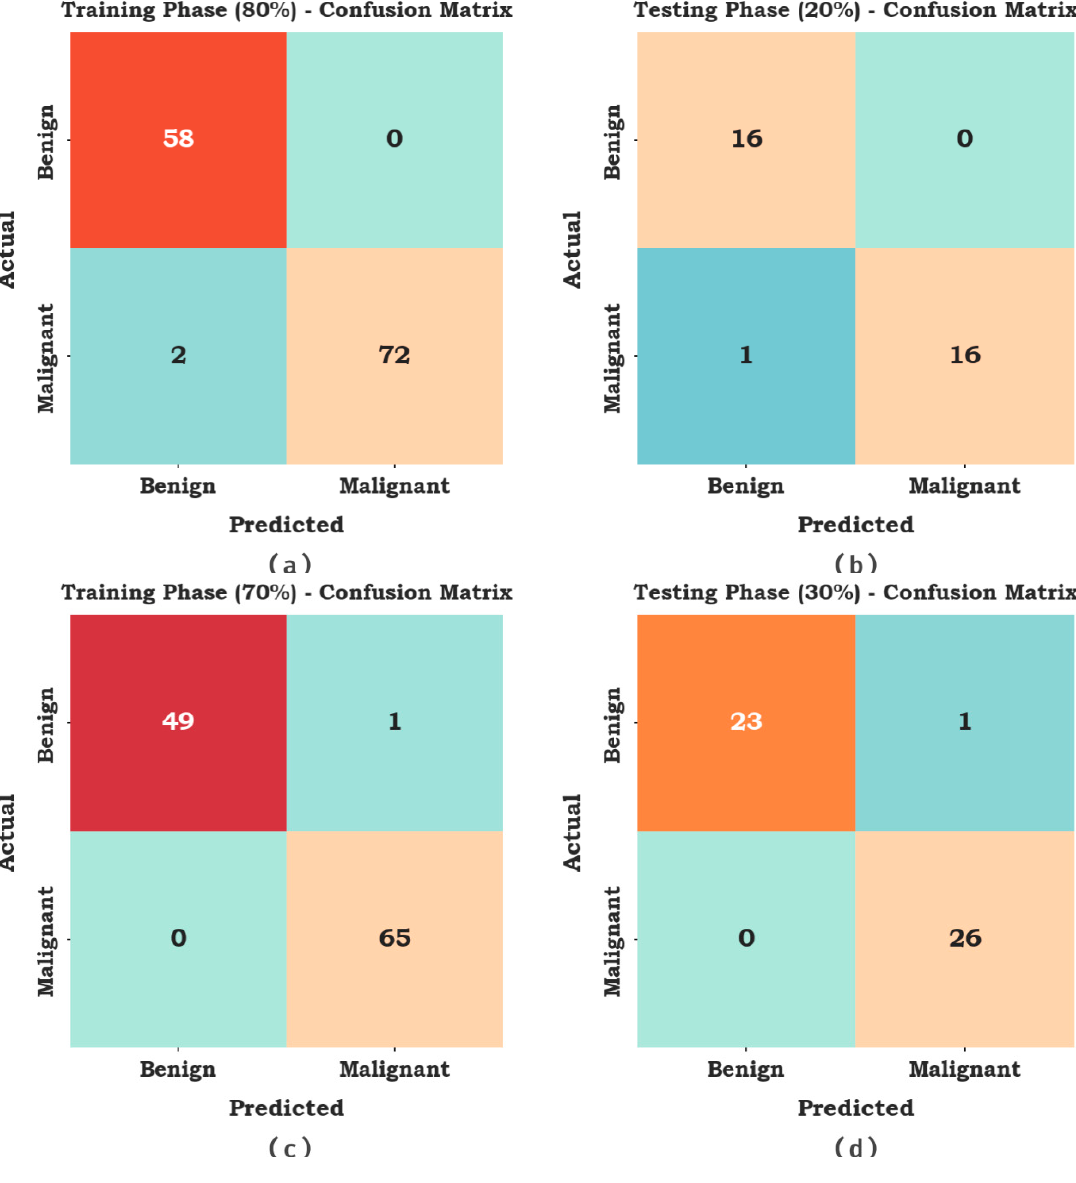
Figure 6. Confusion matrices of the AAOXAI-CD system on dataset-1 ( a , b ) TRS/TSS of 80:20 and ( c , d ) TRS/TSS of 70:30.